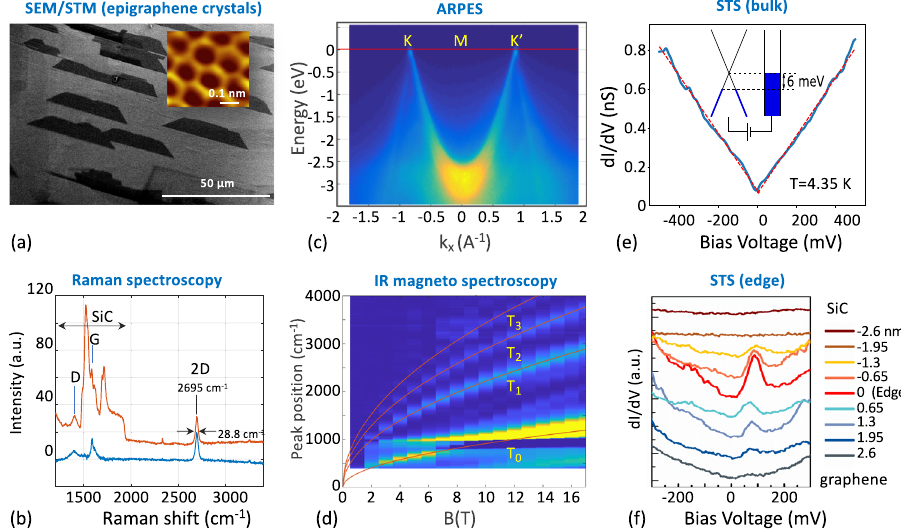
ffiffiffi p B follow the expected characteristic graphene dispersion (indicated by the red lines) con fi rming its monolayer character. e Typical scanning tunneling spectrum ( T =4.4K, I set =400 pA at V bias =500mV), showing the characteristic graphene densityofstates.Alinear fi t(dashedlines)indicatesadopinglevel| E F – E D |<6meV, showingthatthegrapheneischargeneutral. f STSimageatagrapheneislandedge ( T =12.5K, I set =250pAat V bias =2V)takenatvariousdistancesfromtheedgefrom SiCtoinsidetheribbonwithalateralresolutionofabout2nm(tracesaredisplaced vertically for clarity). Note the 0-DoS peak at the edge, similar to that observed in sidewall ribbons 43